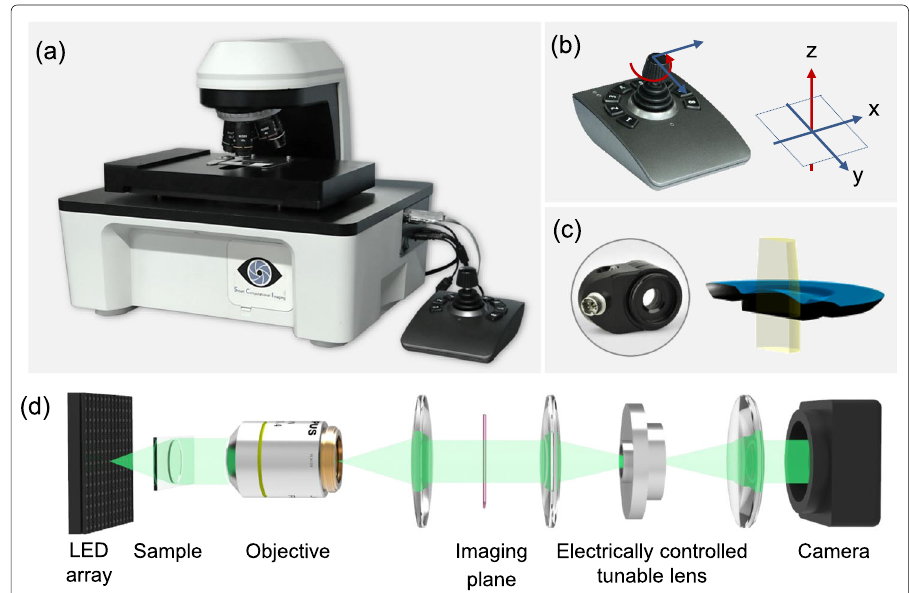
Fig. 11 Schematic diagram of MQP-SCLM. (a) Physical diagram of MQP-SCLM. (b) External control handle for precise adjustment of the displacement of the electronic platform in all three x , y , z directions. (c) ETL for automatic control of defocusing distance. (d) Optical path diagram of the